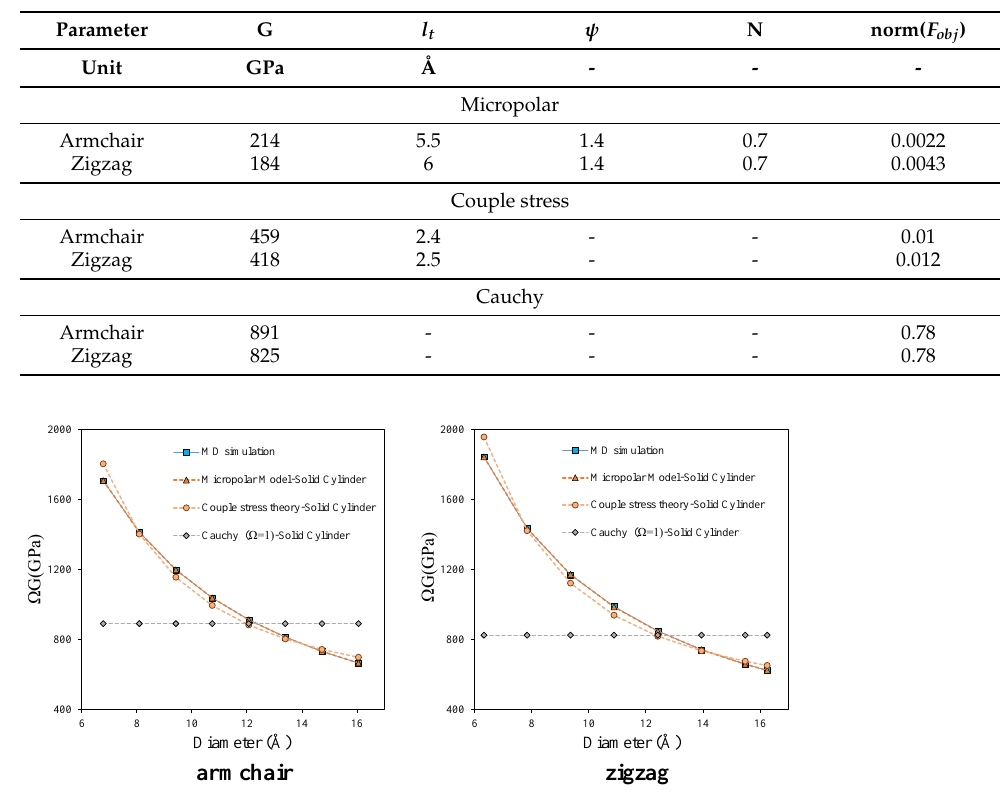
Table 5. Identified material parameters for armchair and zigzag CNTs as solid cylinders.